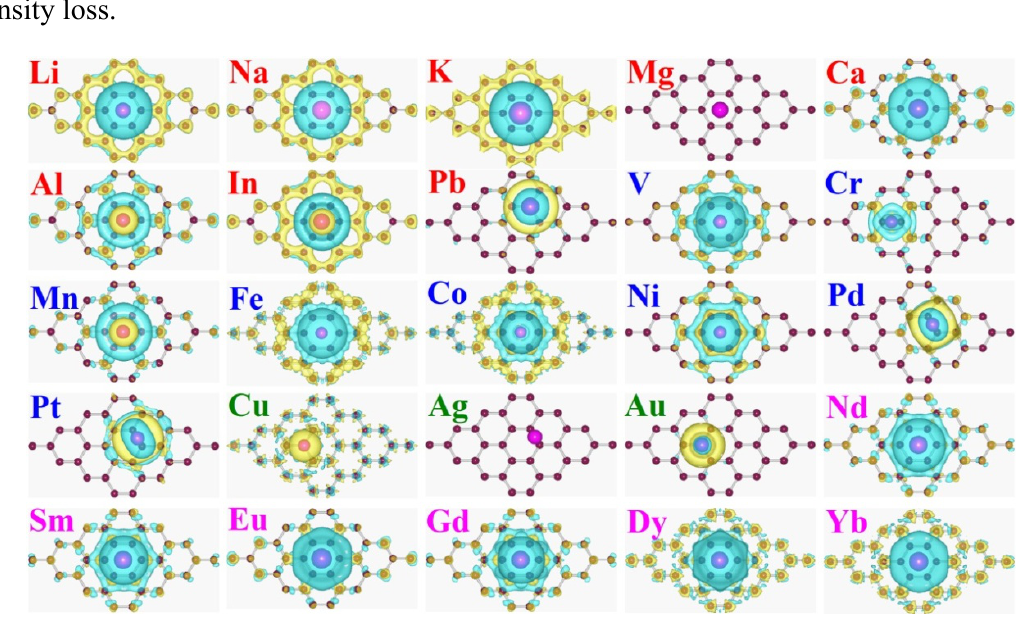
Figure 9. Bonding electron distribution (BED) induced by adatoms adsorption on graphene. The gold color ( i.e. , 0.004 e/Å 3 ) in the 3D plot indicates and increase in the electron density after bonding, and the cyan color ( i.e. , − 0.004 e/Å 3 ) indicates and electron density